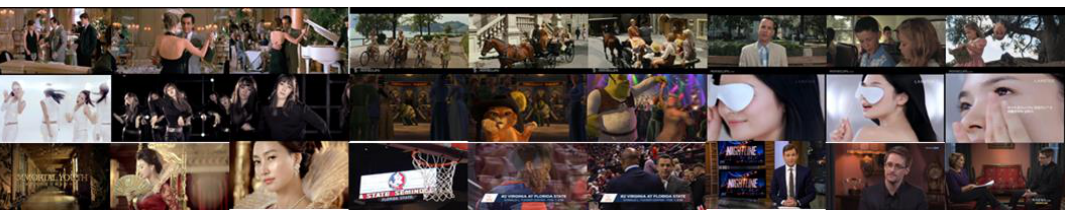
Figure 2. The representative frames from the training videos.